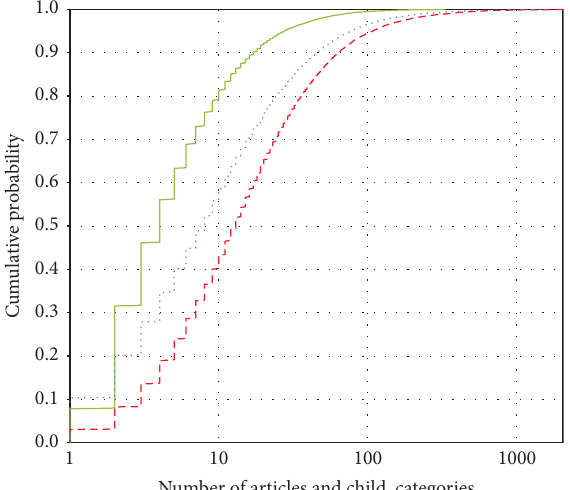
Figure 6: Cumulative distributions of the number of child articles and categories. Dashed: the number of child articles and categories in Wikipedia. Dotted: the number of child articles and categories of nonpruned categories, for our multimedia database. Full line: the number of nonpruned children of nonpruned categories, for our multimedia